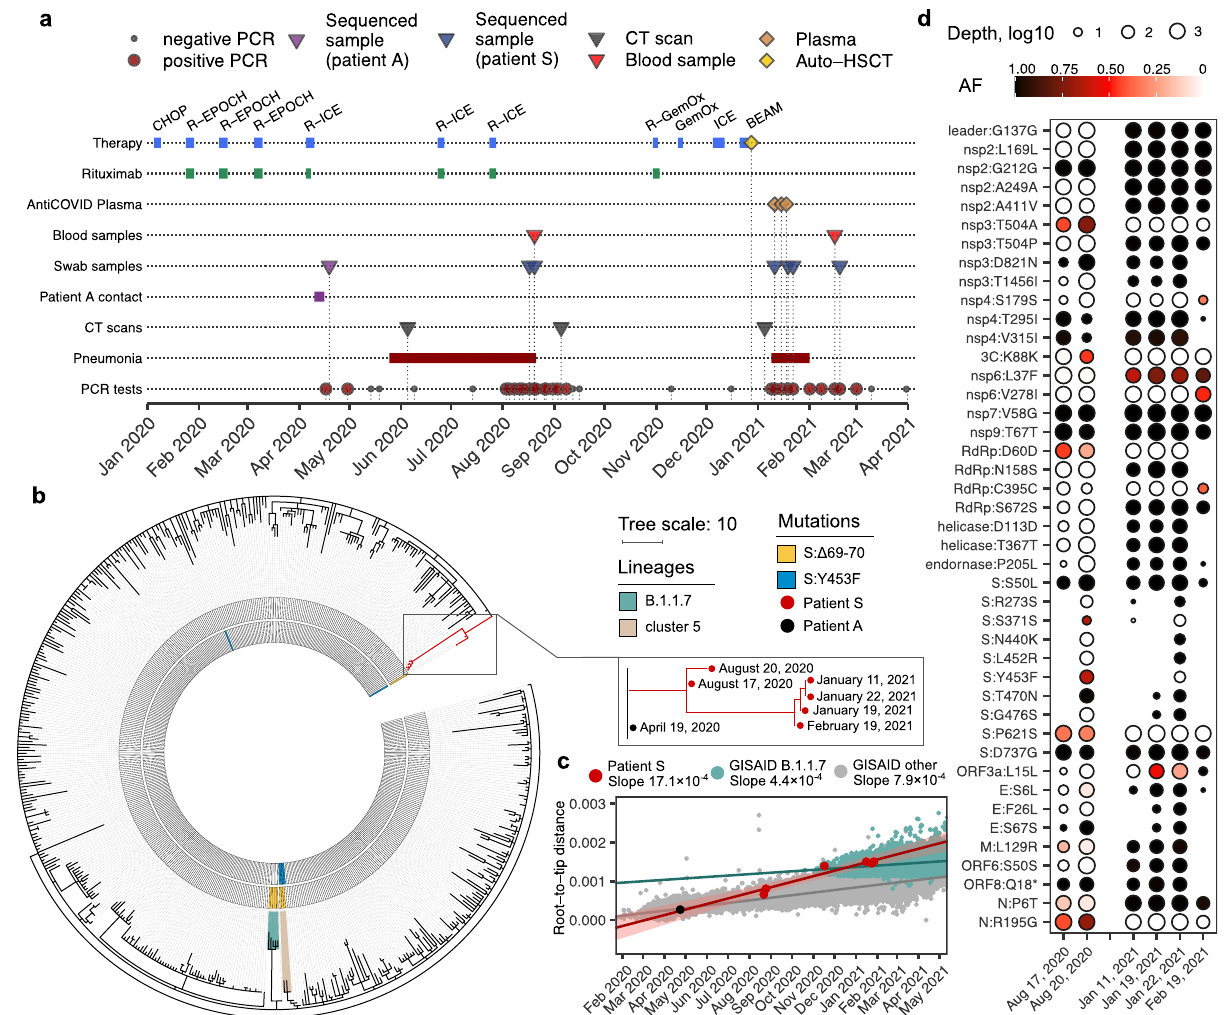
Fig.1|IntrahostevolutionofSARS-CoV-2inpatientS.a ThetimelineofpatientS disease and therapy. b The phylogenetic tree of B.1.1 pruned to contain a random setof1%ofallsamples,includingthepatientAsample(blackdot)andthecomplete clade carrying the patient S samples (red dots). The 2020 samples carried the Δ F combination of mutations (S: Δ 69-70HV and S:Y435F; Supplementary Note 3) marked in the two inner circles in yellow and blue. The B.1.1.7 lineage and cluster 5 are shaded. c Regression of root-to-tip genetic distances vs. sampling dates, for patient S samples (together with the ancestral sample of Patient A), B.1.1.7 lineage